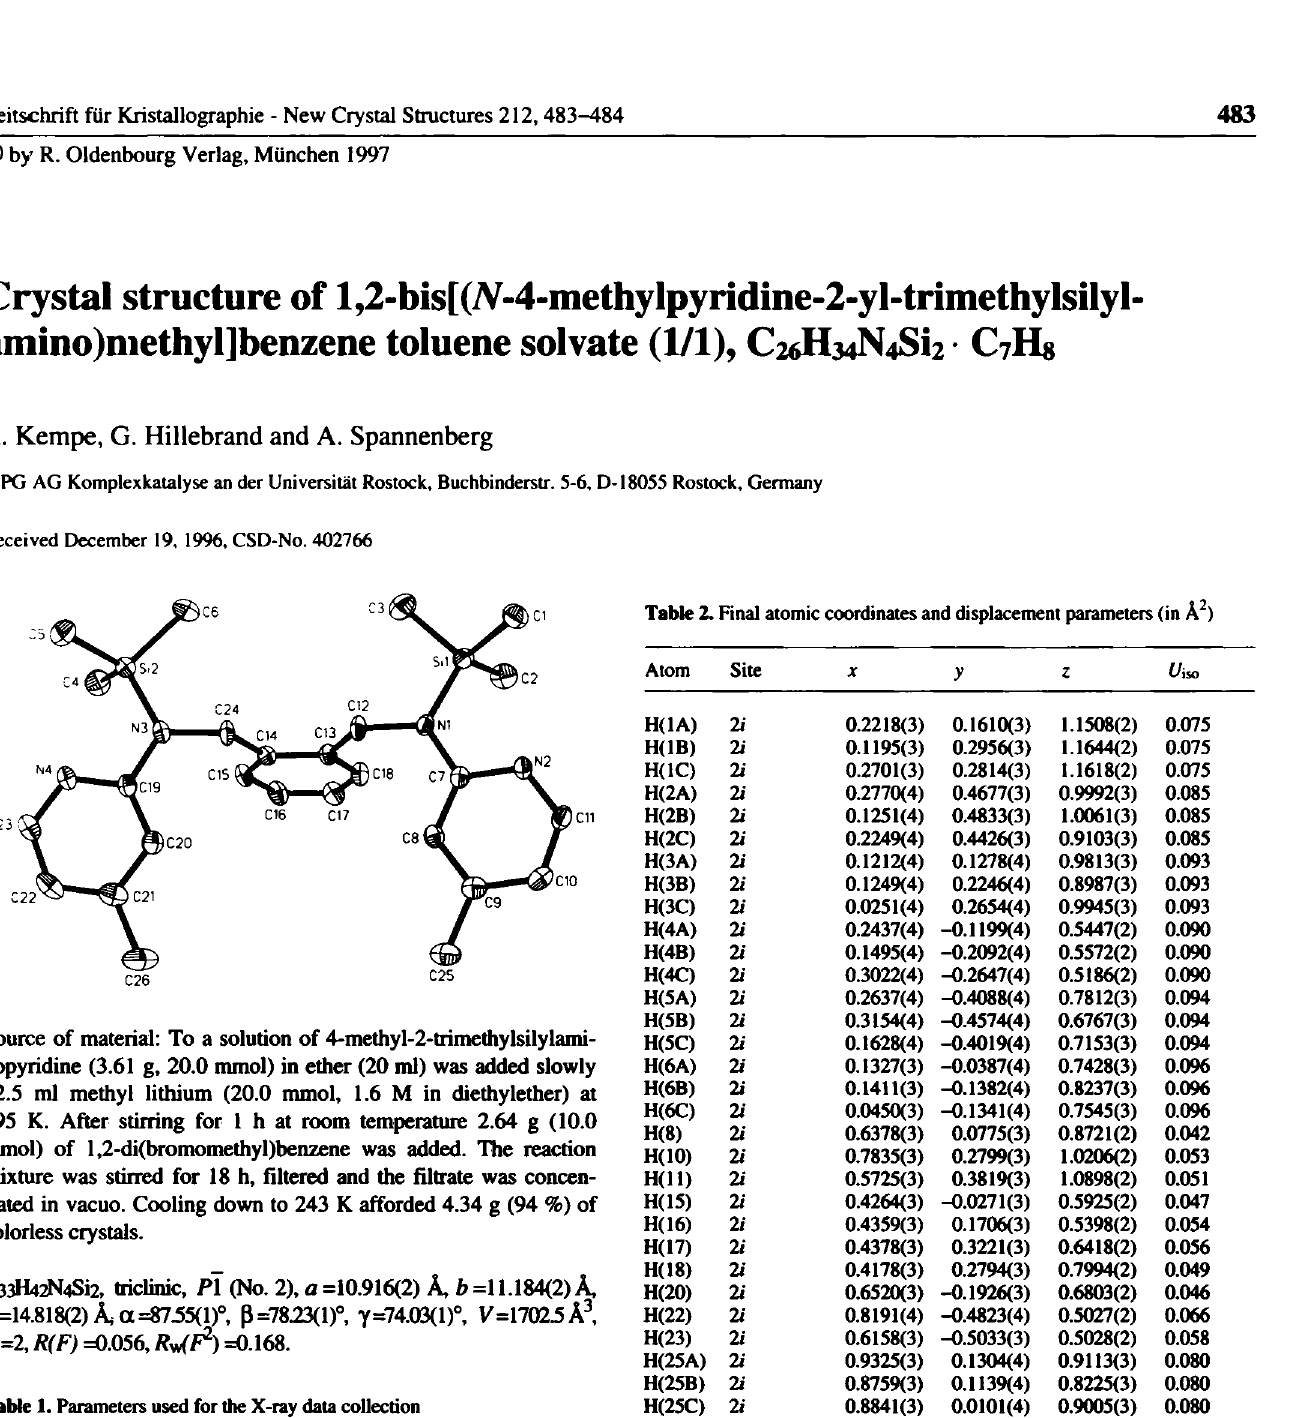
Table 1. Parameters used for the X-ray data collection Crystal: